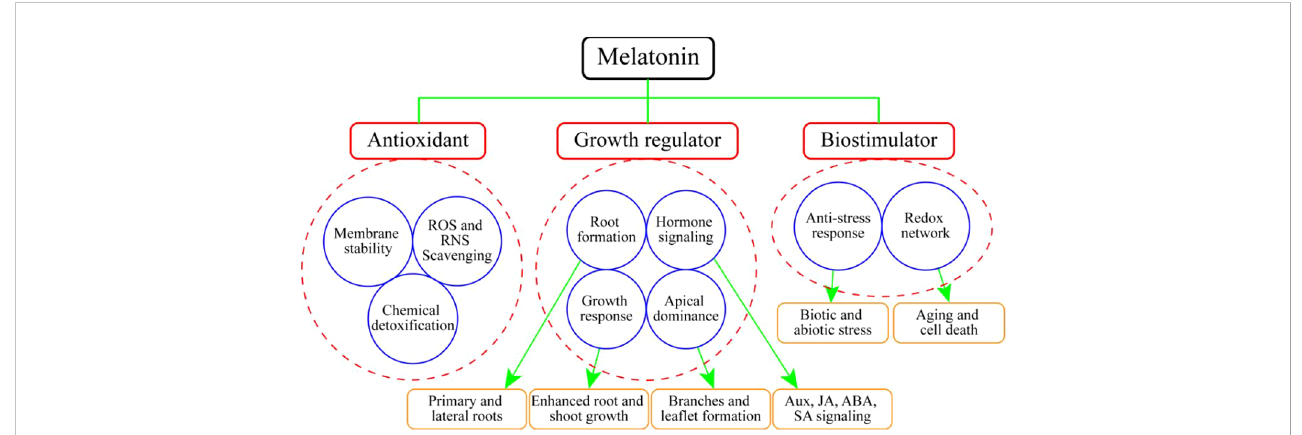
FIGURE 3 Action of melatonin inhorticultural plants as an antioxidant, growth regulator and